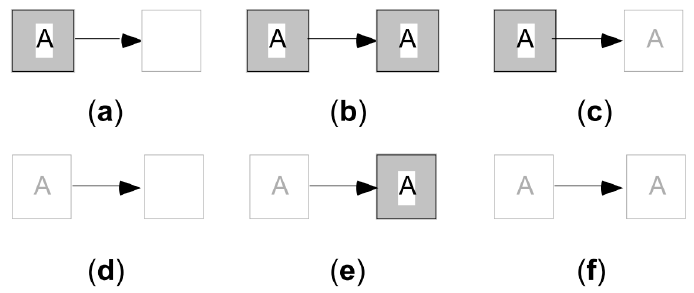
Figure 10. Identity-Based Change , examples of identity operations on single objects: ( a ) create , ( b ) recall , ( c ) reincarnate , ( d ) continue , ( e ) eliminate , ( f ) destroy (redrawn from [43] ).